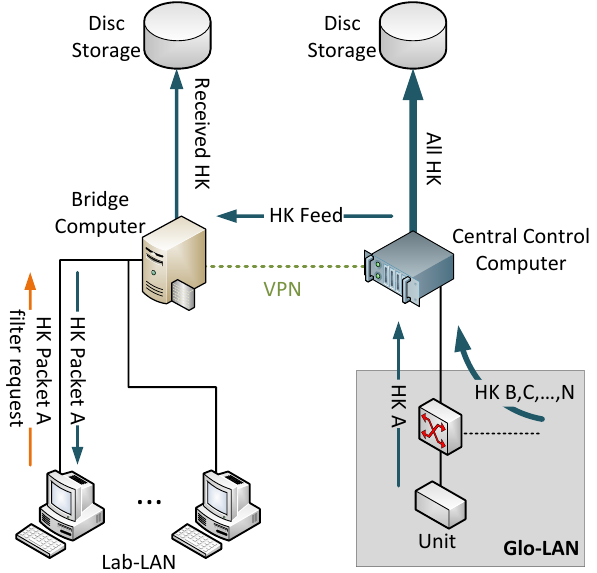
Figure 4. Schematic illustration of the housekeeping (HK) data packet cascading from source to end point. Different units produce different types of HK data packets (identified with the letters A to N), all received and stored at the central control computer. A feed of selected HK data packets is sent down to the bridge computer. Op- erators request specific packet types (here, type A) from the bridge computer through the visualisation tool. Only the requested HK data packet is sent from the bridge computer Spider to the visualisation tool of the operator.